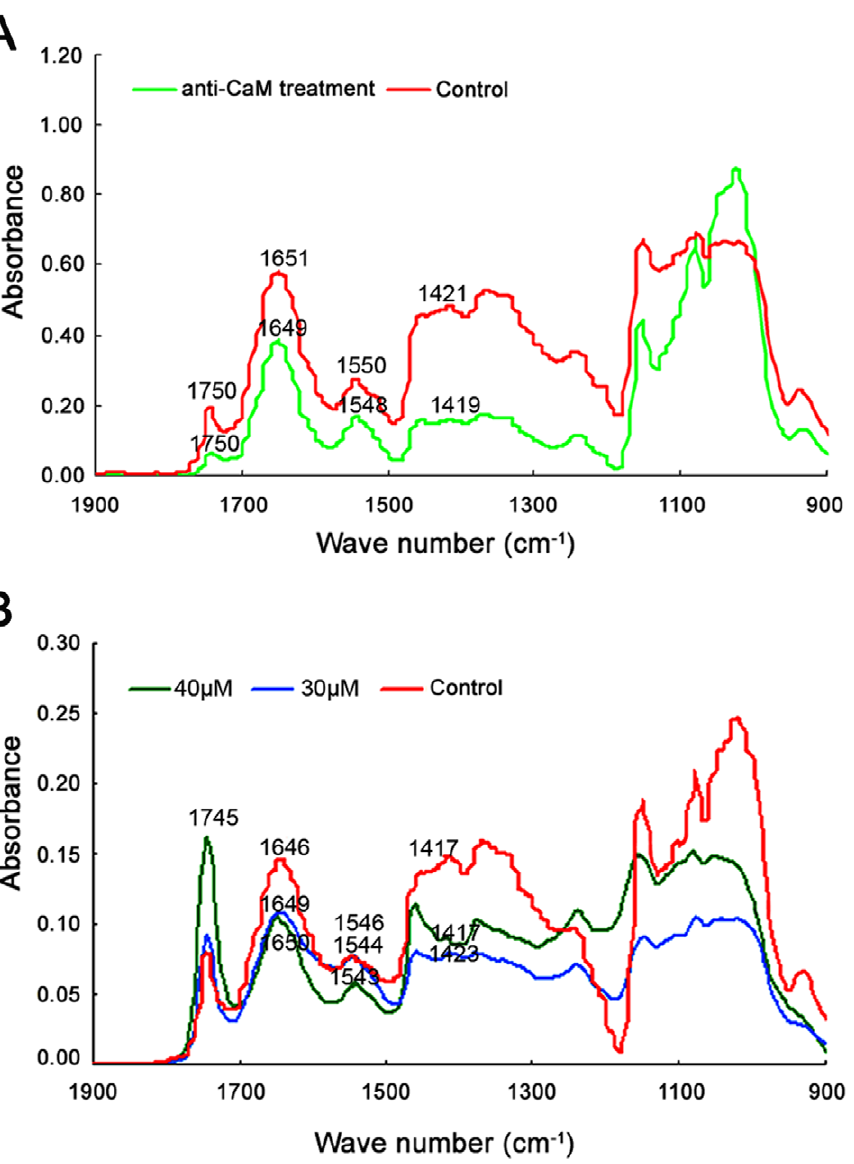
Figure 8. Fourier transform infrared spectra obtained from tip regions of Cedrusdeodara pollen tubes. Three spectra were collected from each sample, and then averaged and baseline-corrected. Triplicate-averaged spectra were used to prepare figures shown in panels. A, FTIR spectra obtained from tip regions of pollen tubes incubated in the presence of 1.5 m g/mL anti-CaM. B, FTIR spectra obtained from tip regions of pollen tubes incubated in the presence of 30 and 40 m M W7-agarose. FTIR spectra showed that esterified pectins (saturated ester at 1745 cm 2 1 ) increased in tube wall while acidic pectins (carboxylic acid at 1415 cm 2 1 ) substantially decreased after treatments with pharmacological agents.